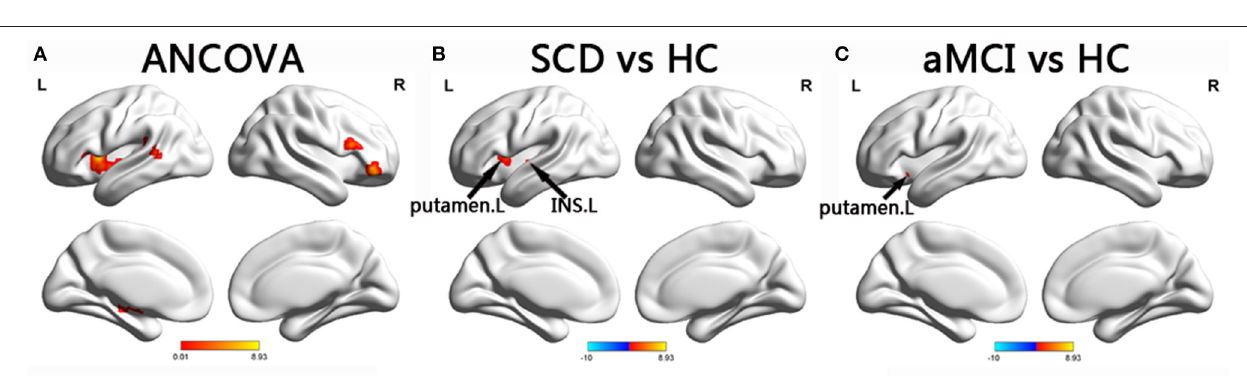
FIGURE 3 | Brain regions exhibiting significant differences in dynamic functional connectivity variability within salience network. (A) Brain regions showing significant differences in dynamic functional connectivity variability within the salience network across three groups, including SCD, aMCI, and HC ( p < 0.05, the cluster size > 19 voxels). (B,C) Results of post hoc analysis in voxel-wise analysis (TFCE-FWE corrected, cluster size > 9, p < 0.05). aDMN, anterior default mode network; pDMN, posterior default mode network; aMCI, amnestic mild cognitive impairment; SCD, subjective cognitive decline; HC, healthy controls; INS, insula; L,